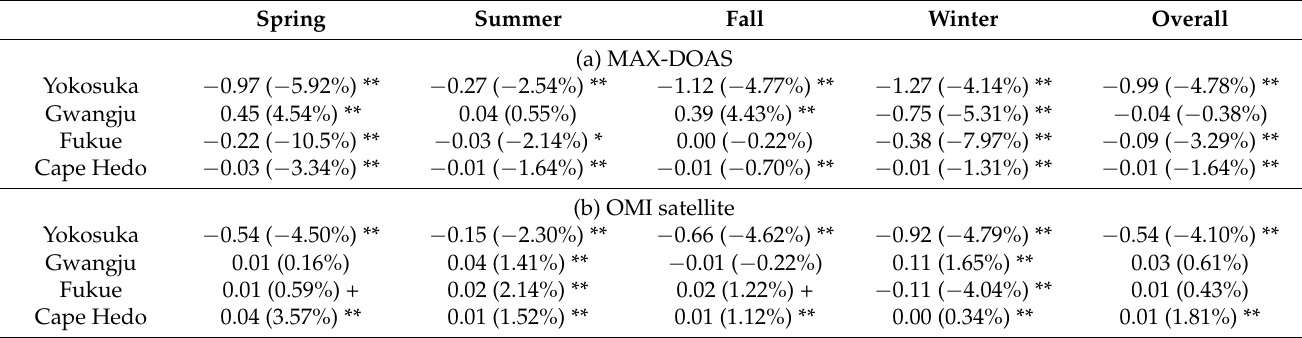
Table 2. Observed seasonal and overall Theil-Sen slopes of tropospheric NO 2 vertical column density (NO 2 TropVCD; × 10 15 molecules cm − 2 ) from the time-matched MAX-DOAS and OMI satellite data at four sites from 2007–2017. a The values in parentheses indicate the percentage of Theil-Sen slopes to the mean NO 2 TropVCD corresponding time scale. Spring Summer Fall Winter Overall (a) MAX-DOAS